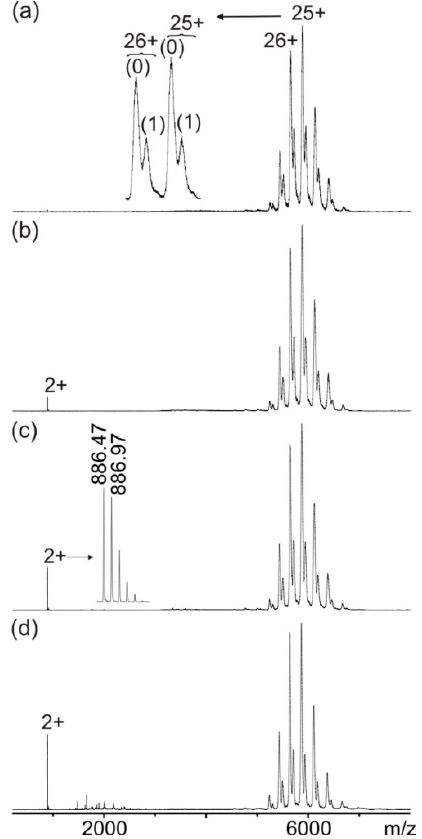
Figure 3. Nano-ESI mass spectra of peptide 4 (ENREVGDWLKNIDAL)—anti-hcTn I antibody immune complex with increasing collision cell voltage differences ( ∆ CV): ( a ) 4 V, ( b ) 16 V, ( c ) 30 V, and ( d ) 80 V. Charge states are given for the immune complexes (right ion series), and the inlet in ( a ) shows a zoom of the 25+ and 26+ ion signals of the antibody (0) and the immune complexes (antibody plus one peptide (1) and antibody plus two peptides (2)). Charge states and m/z values for peptide ion signals are given on the left, and the inlet in ( c ) shows a zoom of the isotopically resolved doubly protonated peptide ion signal. Antibody fragment ion signals are visible between m/z 1200 and m/z 2300 in ( d ). Solvent: 200 mM ammonium acetate, pH 6.7.